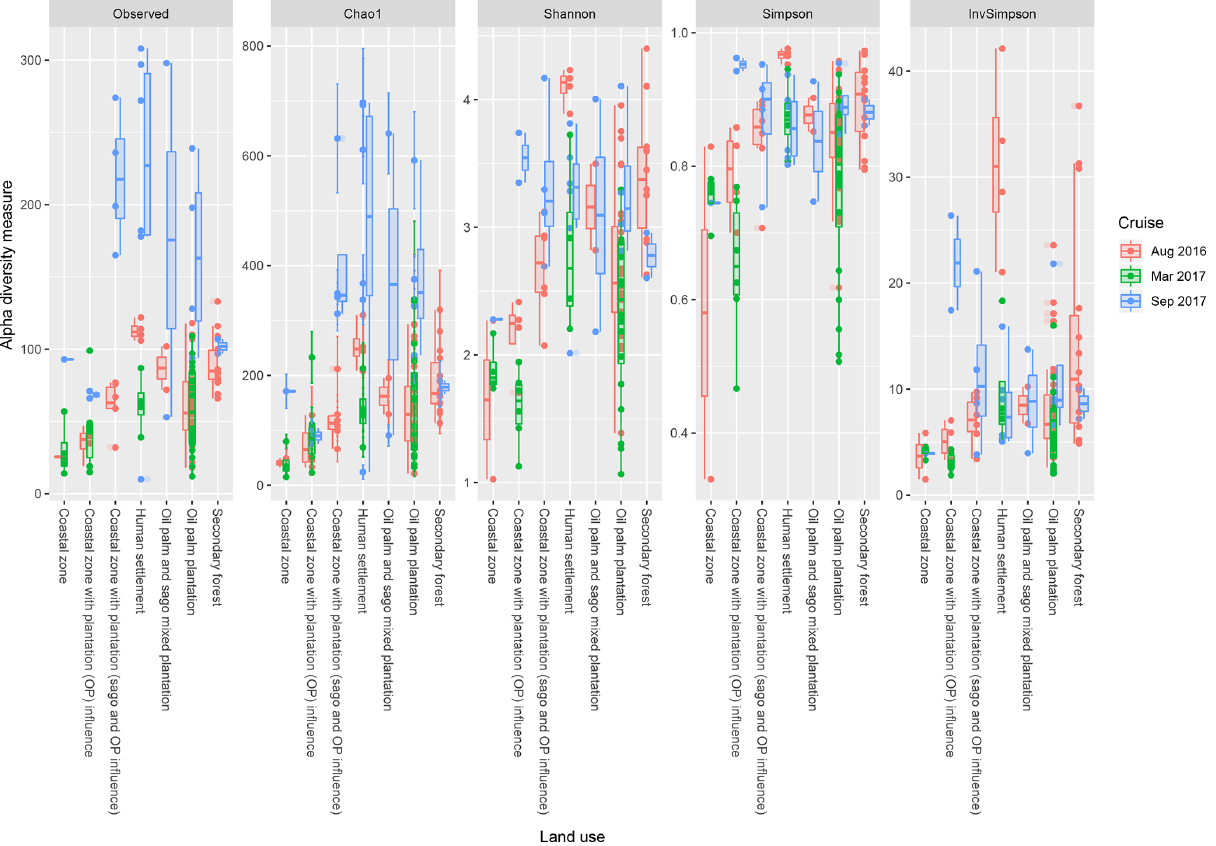
Figure 5. The calculated α -diversity indices (observed, Chao1, Shannon, Simpson and inverse Simpson) of the land use types, which include coastal zone, coastal zone with plantation (OP) influence, coastal zone with plantation (sago and oil palm influence), human settlement, oil palm and sago mixed plantation, oil palm plantation, and secondary forest.